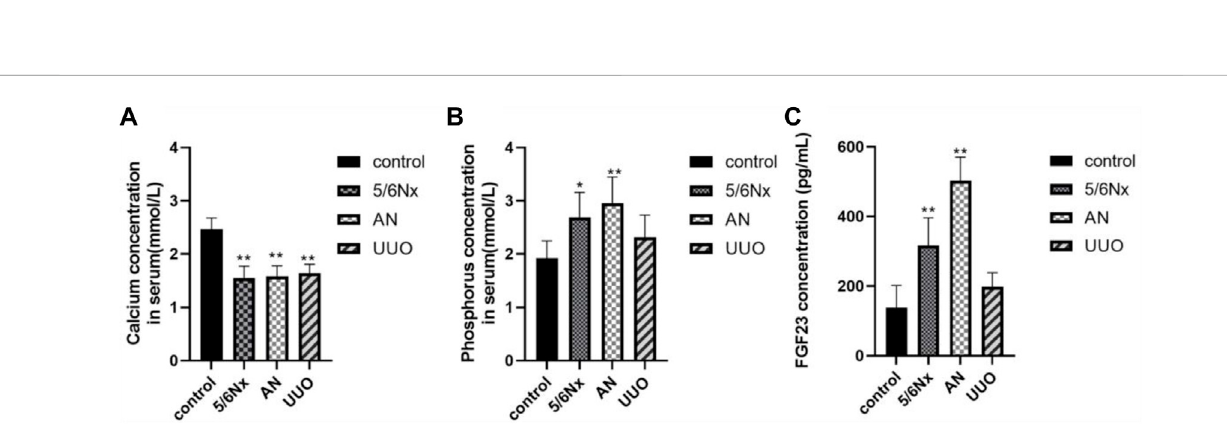
Levels of Scr and BUN in serum in different models. (A) Levels of Scr in serum at the fi fth week and eighth week. (B) Levels of BUN in serum at the fi fth week and eighth week. * p < 0.05 and ** p < 0.01 vs. the control group. Data are presented as mean ± SD. n = 6.